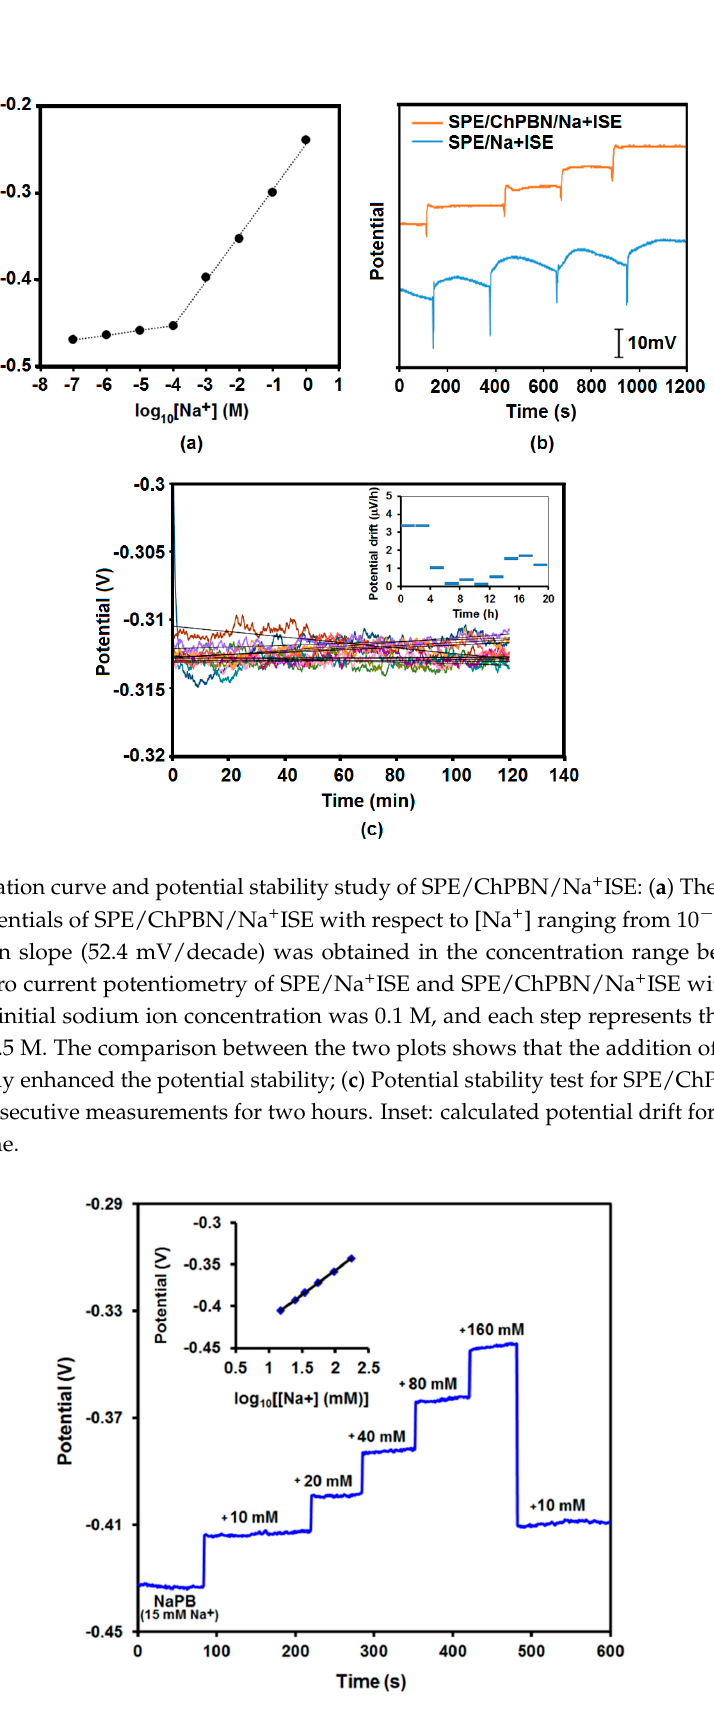
Figure 7. Potential responses of SPE/ChPBN/Na + ISE to increasing concentrations of sodium in the PBS solution. The inset shows a Nernstian slope of 58